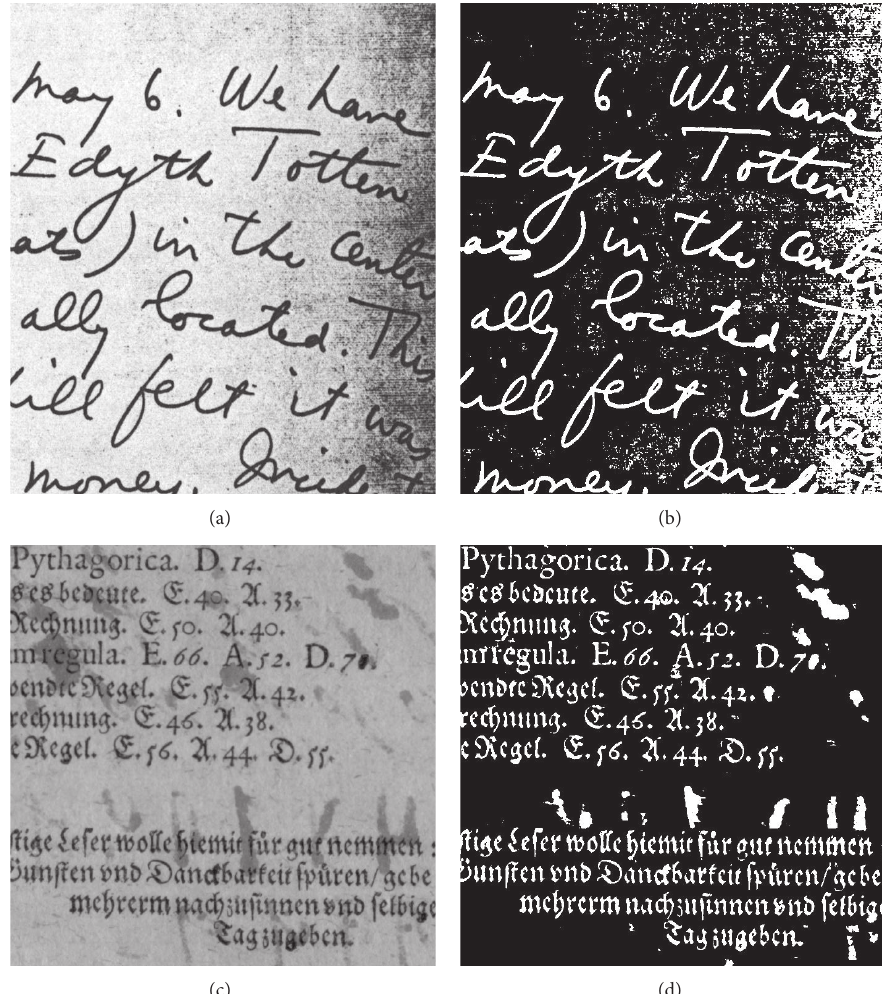
Figure 10: Test images used to show the applicability of the architecture for local adaptive thresholding. ((a) and (c)) The input images; ((b) and (d)) thresholded images by using the Bernsen algorithm with a 31 × 31 window and 𝑘 = 60